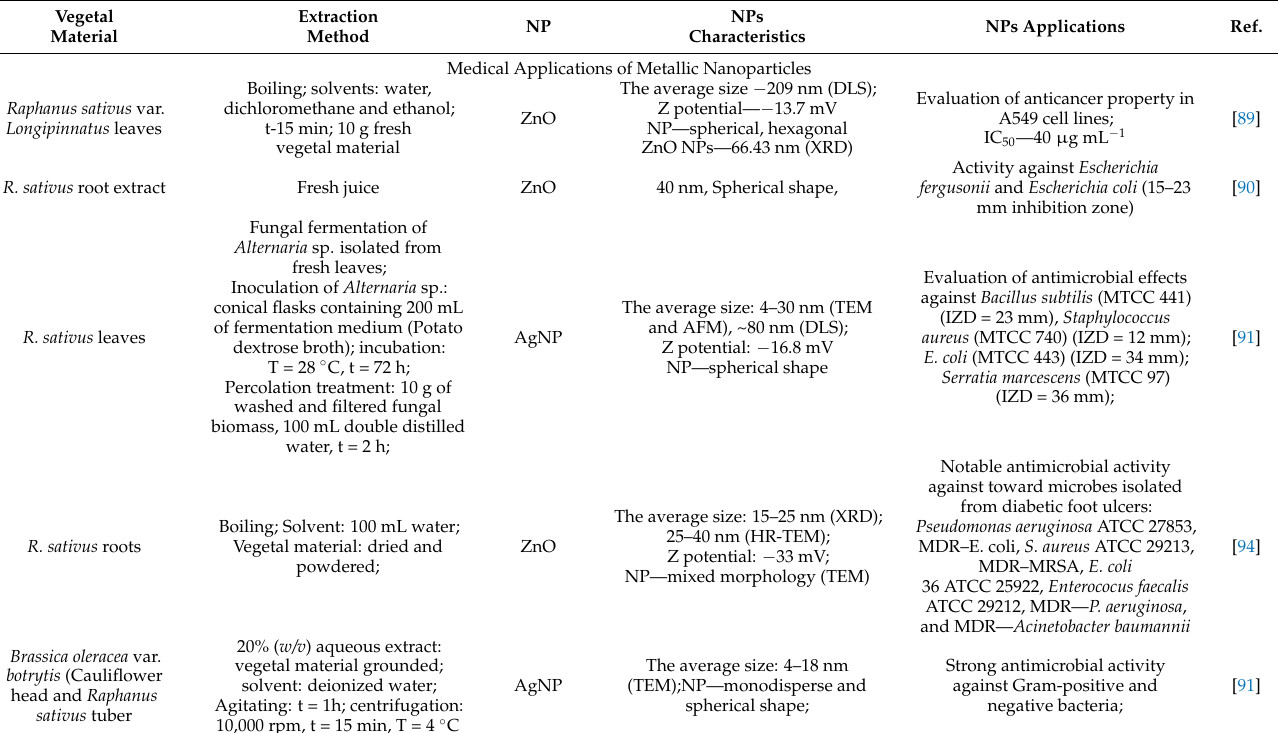
Table 2. Application of Brassica genus in green